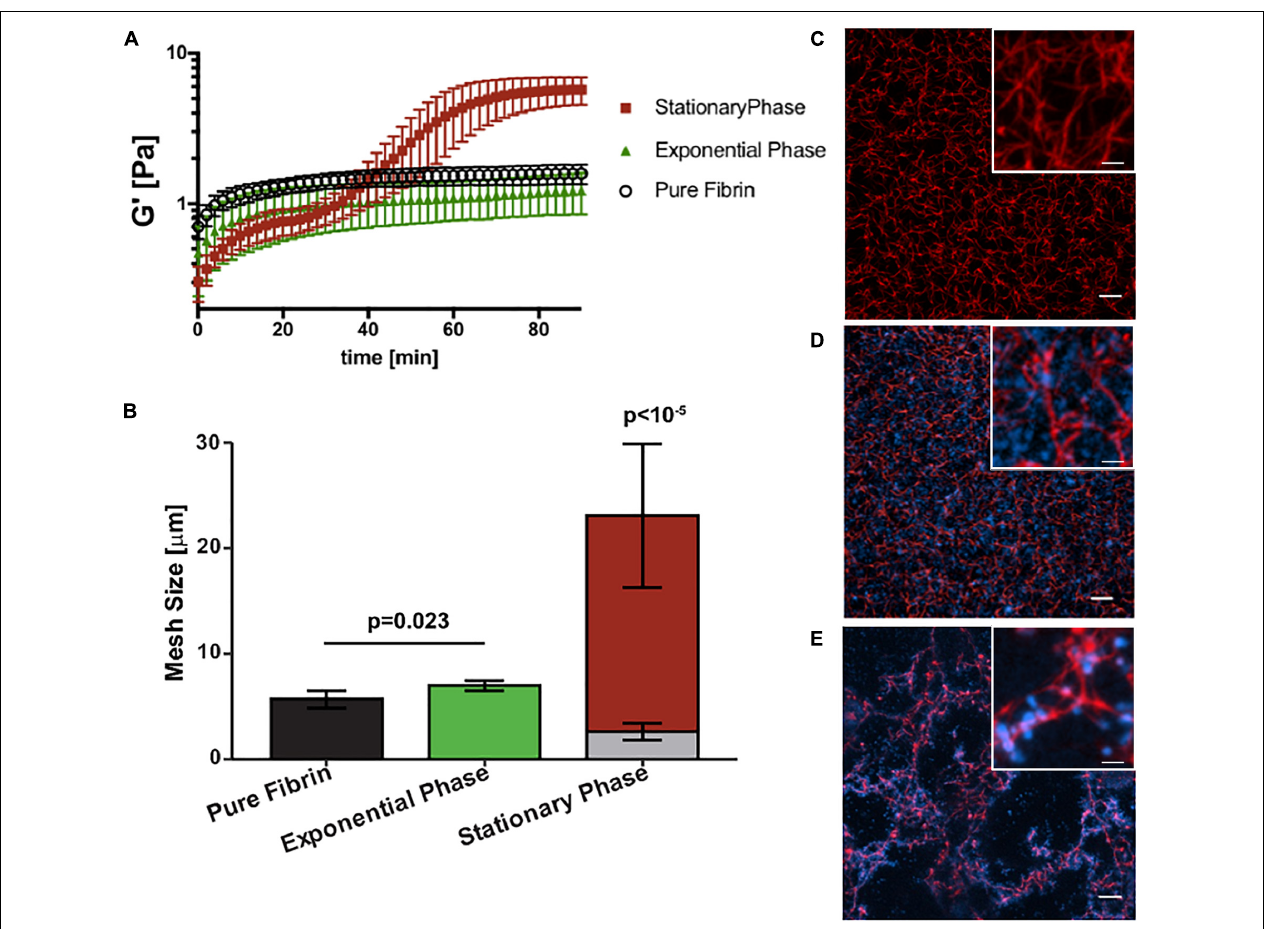
FIGURE 3 | Staphylococcus epidermidis alters fibrin elasticity and structure in a growth phase dependent manner. (A) Time sweep of elastic modulus, G (cid:48) , of pure fibrin clot (0.5 mg/mL) (black) and fibrin clots infected by stationary and (red), exponential phase S. epidermidis (green). Error bars denote standard deviation with N = 3. (B) Mesh size characterization of steady-state pure fibrin clot and fibrin clots infected with stationary and exponential phase S. epidermidis . Error bars denote standard deviations with N = 5. Note that the stack bars (gray and red) in the stationary phase condition indicate two characteristic mesh sizes. (C) Axial projections of a pure fibrin clot, a fibrin clot infected with (D) exponential and (E) stationary phase S. epidermidis . Scale bar = 10 m. Insets with higher magnification, scale bars = 2.5 µ m. Fibrin is red and cells are blue. In all cases, cell concentrations are all 4 × 10 9 cells/mL and fibrin concentration is 0.5